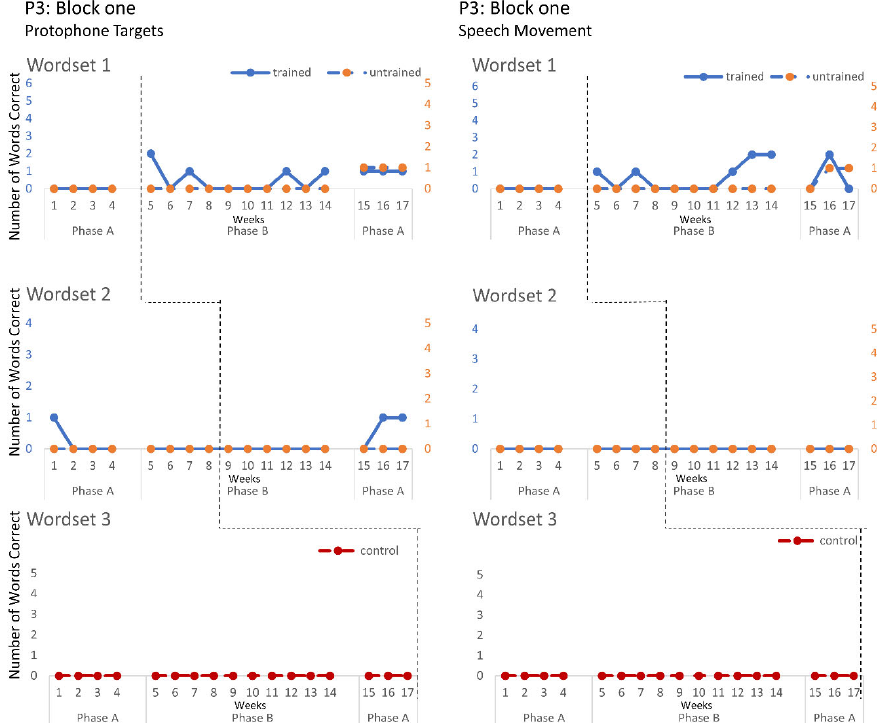
Figure 8. Accuracy of performance on the speech probes as scored for protophone target ( left ) and motor-speech movements ( right ) block one, participant 3.